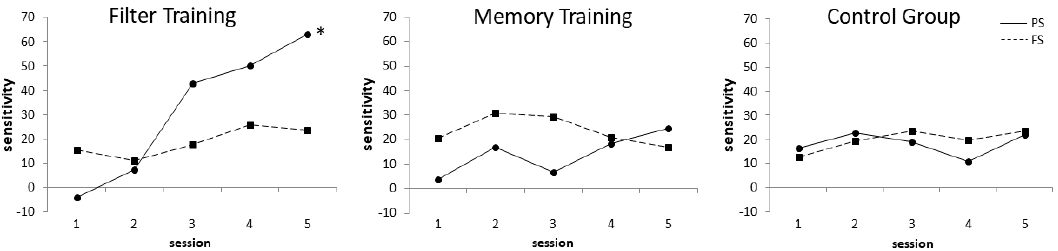
Figure 4. Payoff (PS) and Frequency (FS) Sensitivity. PS = (C + D) – (A + B); FS = (B + D) – (A + C), * p < 0.001 for day 1 vs. day 5 comparison.